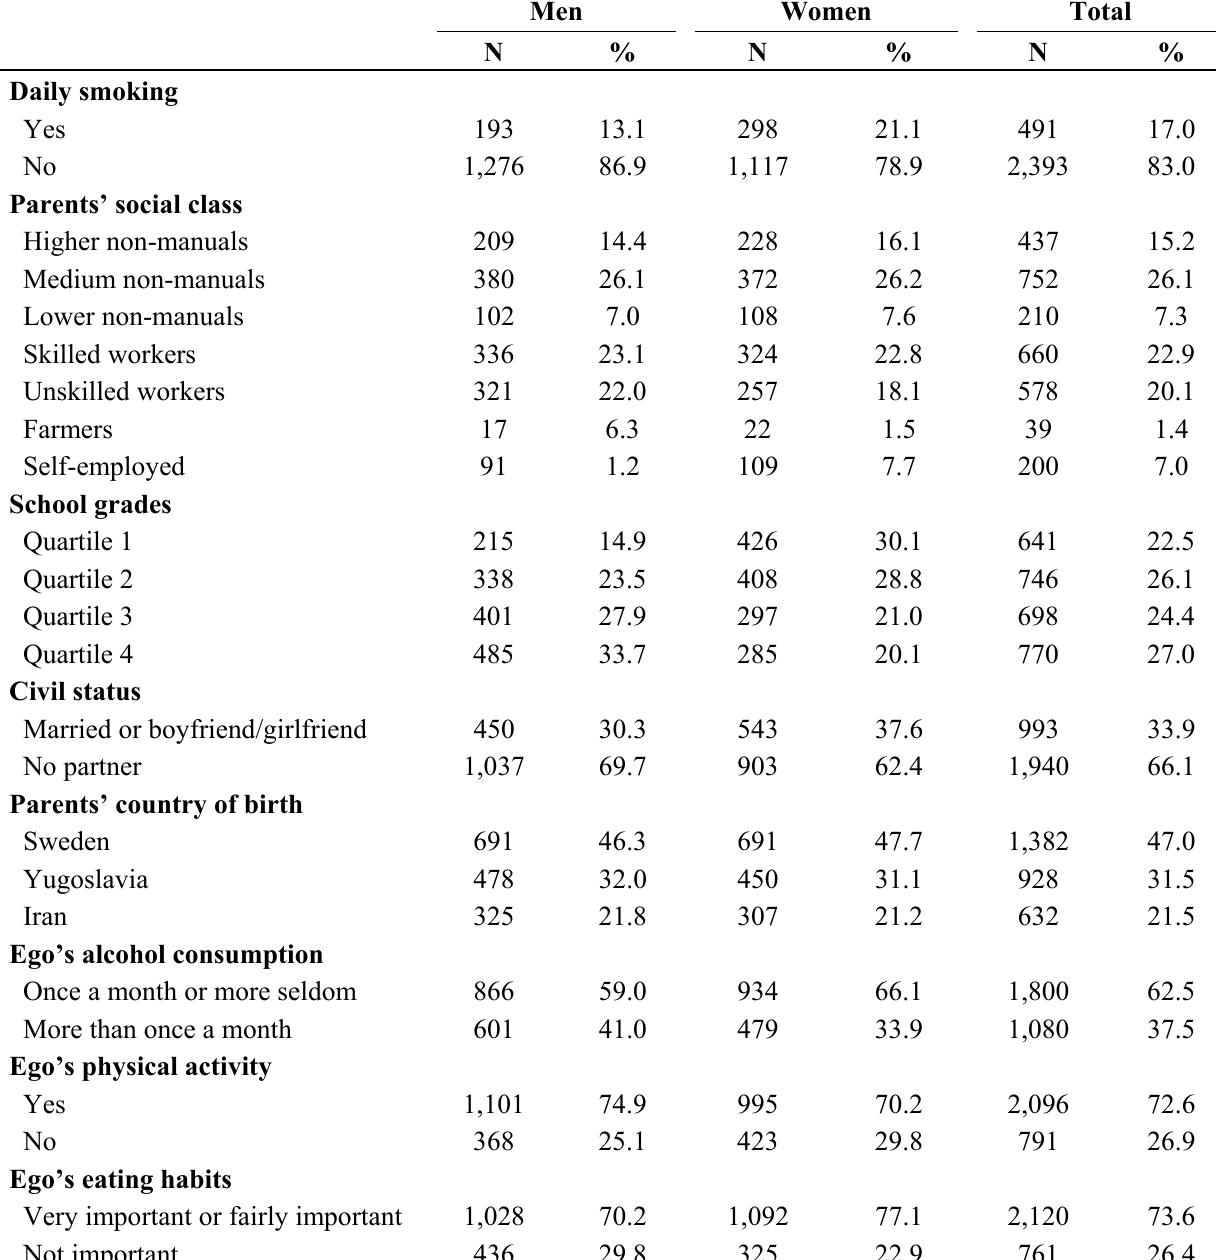
Table 1. Descriptive statistics of smoking prevalence and control variables included in the study sample, 19-year-old men and